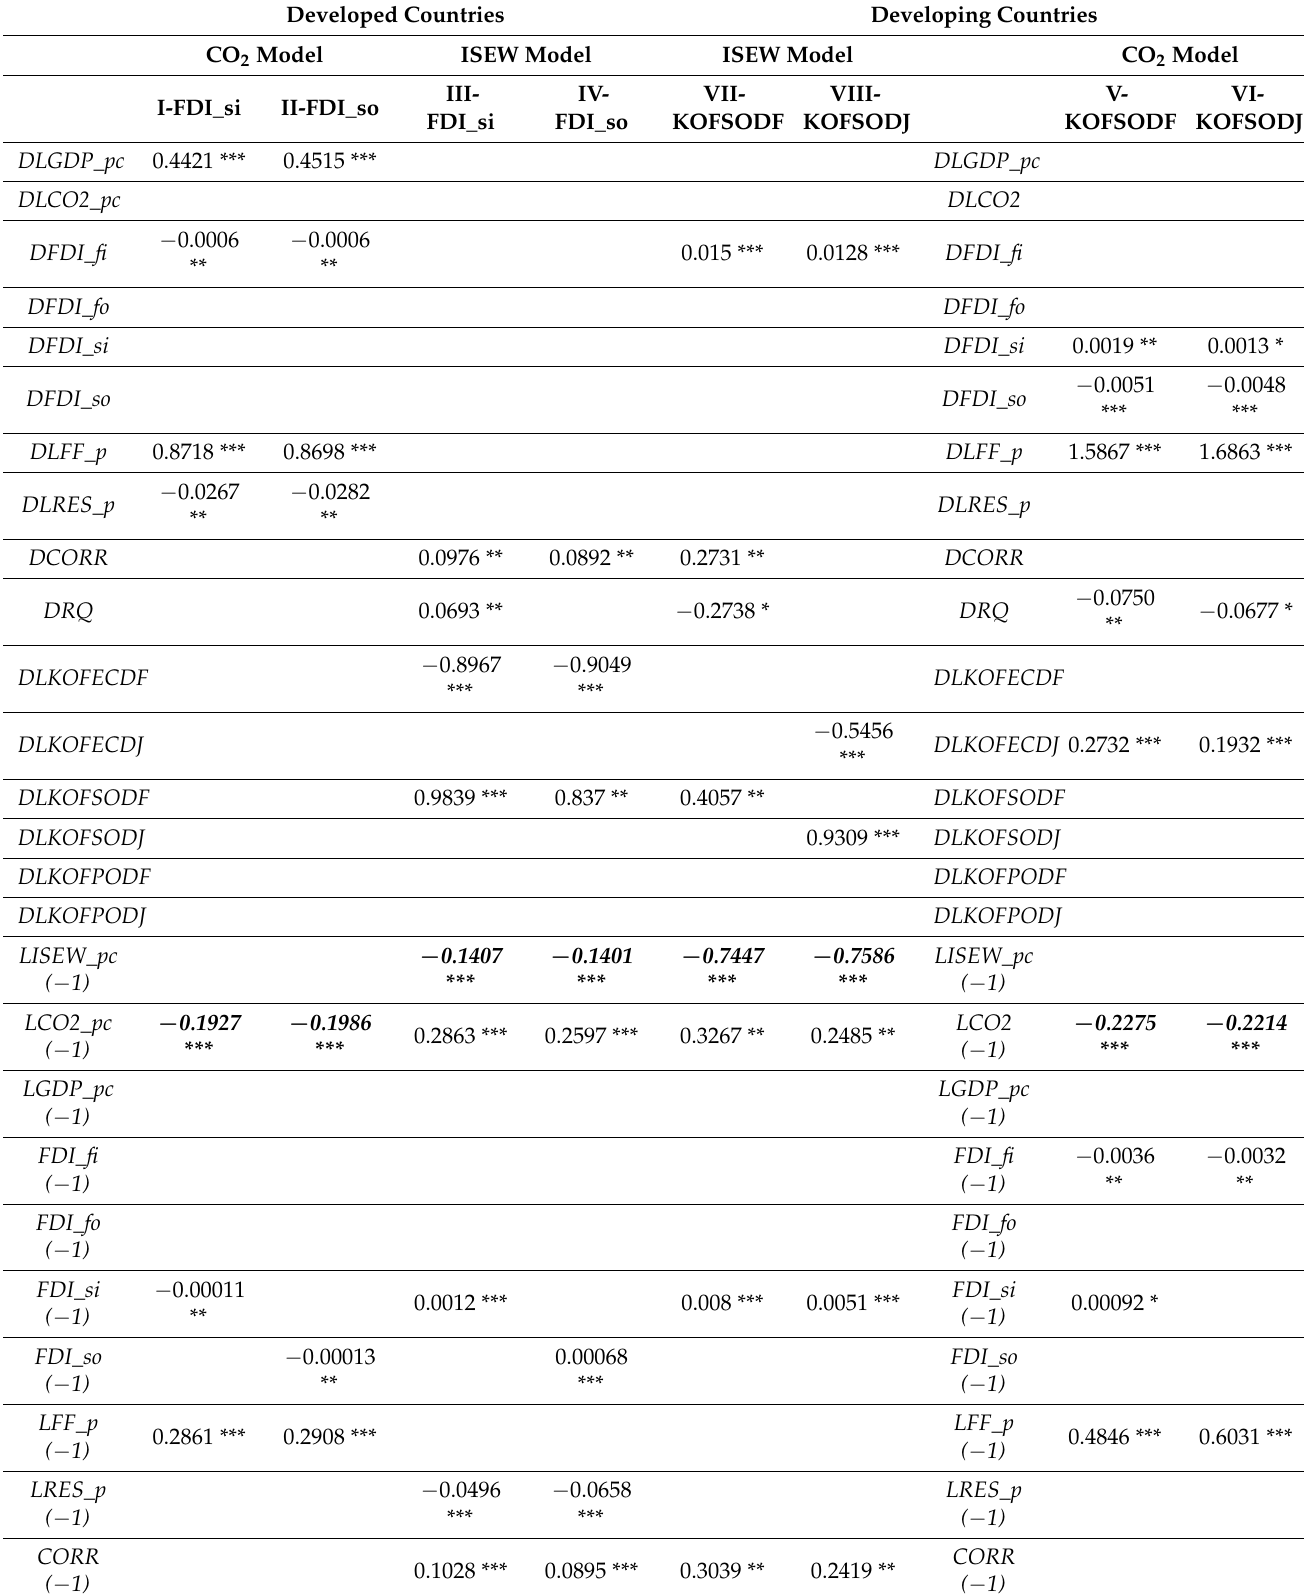
Table 11. Estimations of Autoregressive Distributed Lag (ARDL) model. Developed Countries Developing Countries CO 2 Model ISEW Model ISEW Model CO 2 Model VIII- KOFSODF KOFSODJ